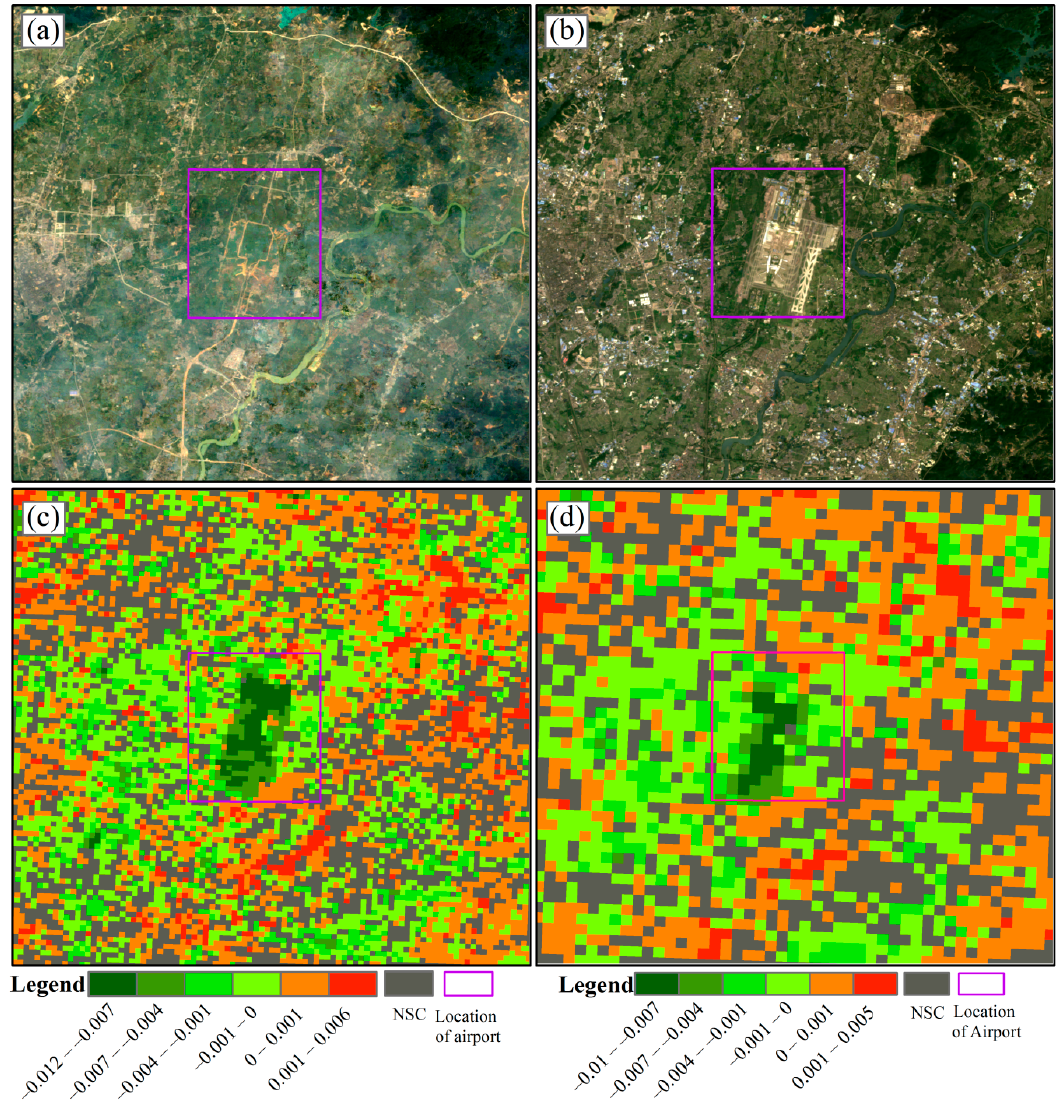
Figure 9. Local comparison of Q1-TR and A1-TR: (a) Landsat image of 2000 in the PRD; (b) Landsat image of 2015 in the PRD; (c) part result of Q1-TR in the PRD; (d) part result of A1-TR in the PRD.